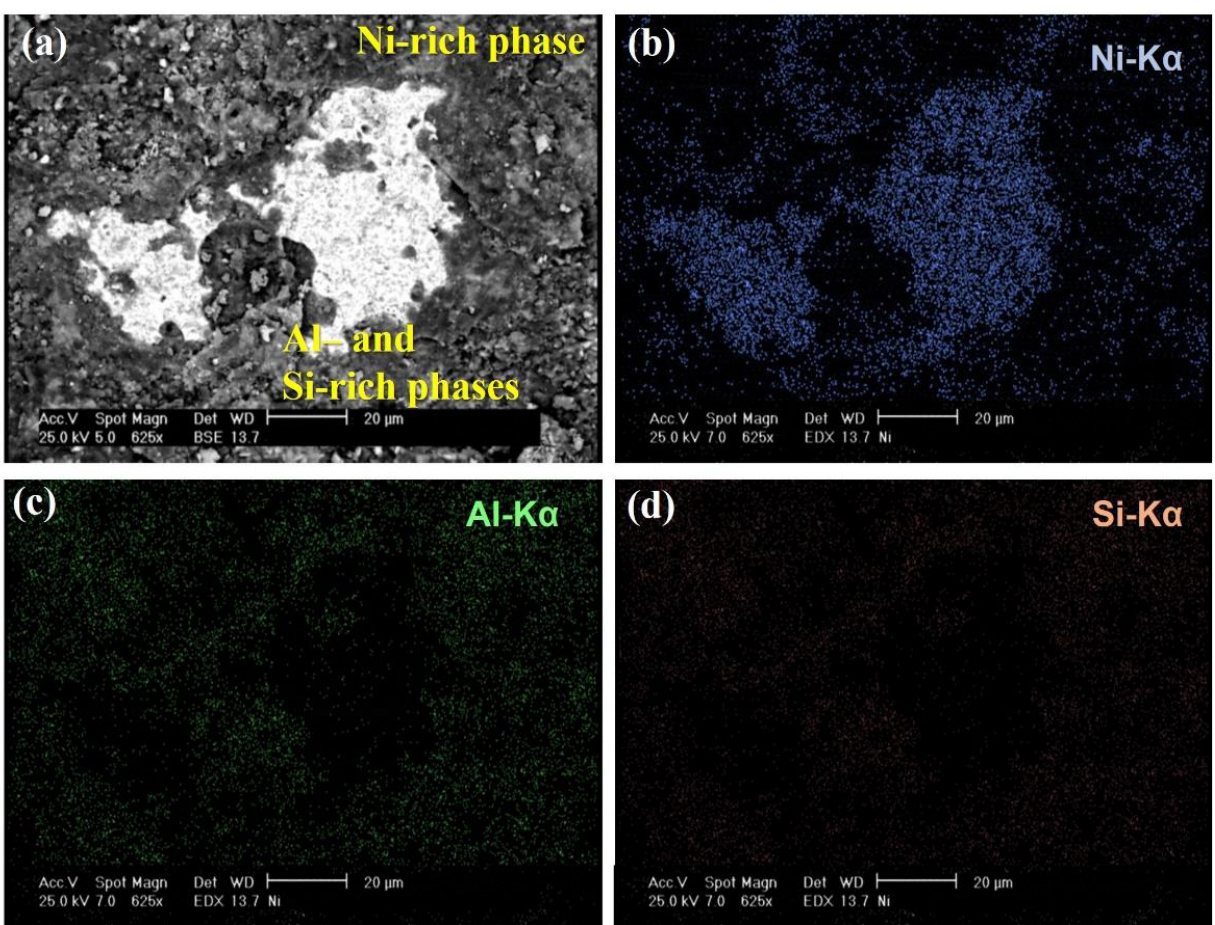
Figure 9. The magnified surface SEM image, ( a ) as well as elemental mapping for Ni ( b ), Al ( c ), and Si ( d ) for the Ce0Si3 coating sample after 50 cycles of oxidation test at 1100 °C.